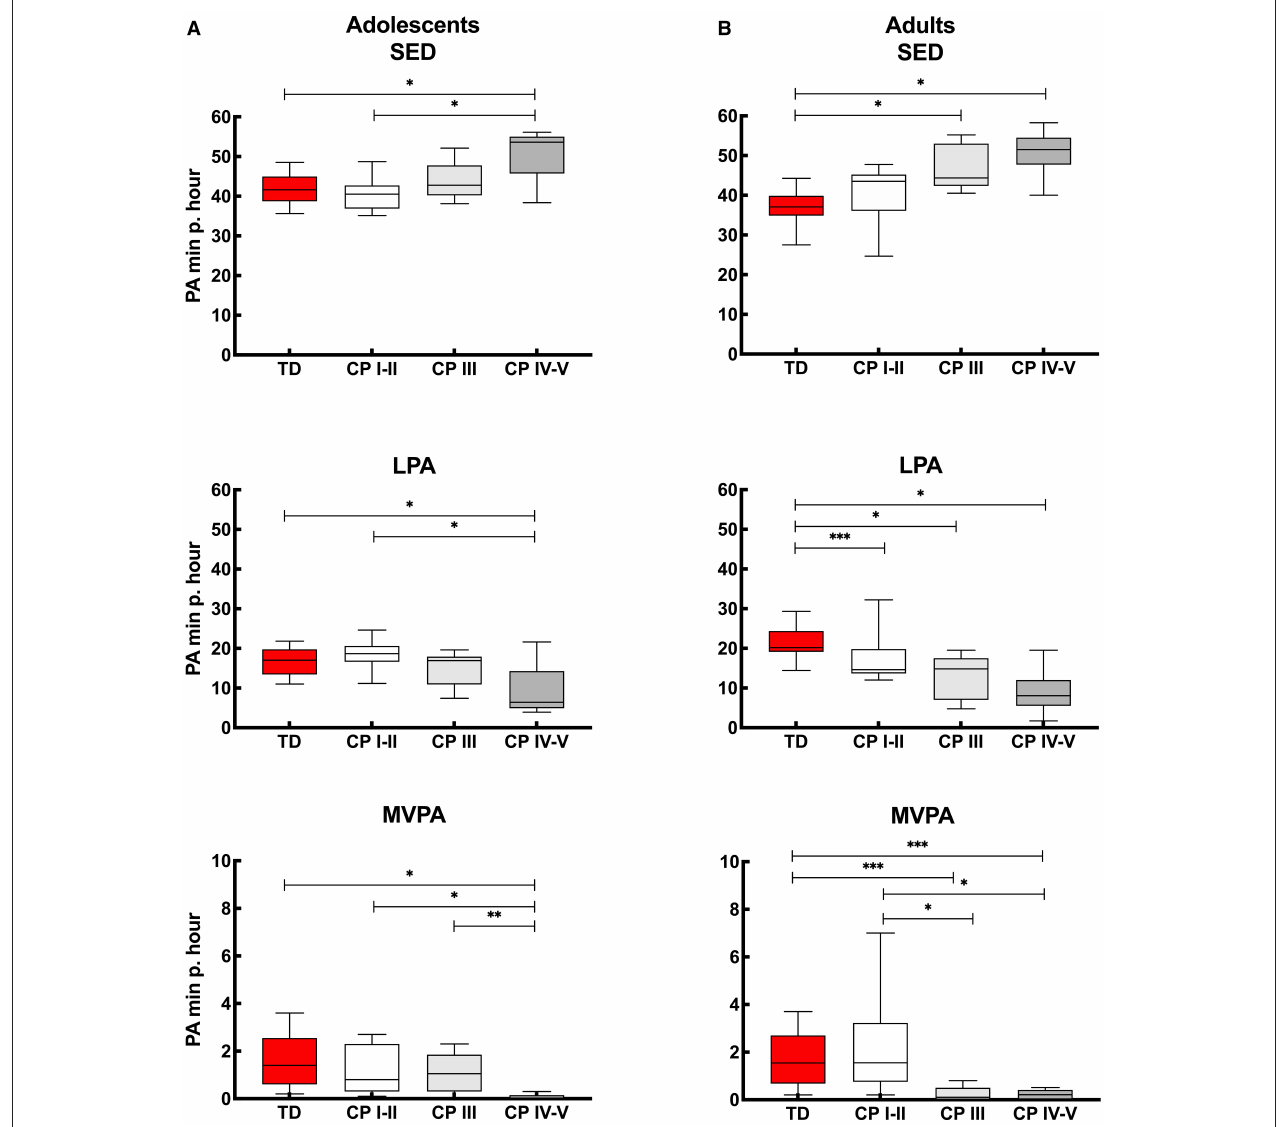
FIGURE 3 | Box and whisker plots for time spent in sedentary (SED), low physical activity (LPA) and moderate to vigorous physical activity (MVPA) using Freedson cut-points of (A) adolescents and (B) adults with cerebral palsy (CP) and typically developing peers (TD). CP groups include CP I-II, participants with CP classified in Gross Motor Functional Classification System (GMFCS) level I and II; CP III, participants with CP classified in GMFCS level III; CP IV-V, participants with CP classified in GMFCS level IV and V. *Significant difference found for “whole week,” “weekdays” and “weekend days;” **significant difference found for “whole week” and “weekend days;” ***significant difference found for “whole week” and “weekdays” ( p <